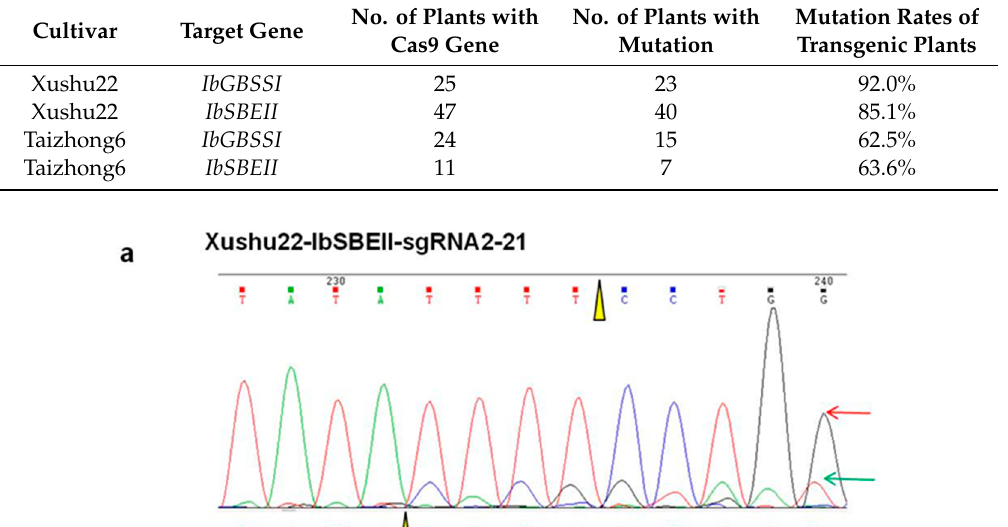
Table 1. Mutation rates of CRISPR / Cas9 in sweet potato. Figure 2. Schematic representation of the workflow designed to analyze targeted gene mutations of CRISPR/Cas9 editing. Transgenic lines were identified by PCR detection of Cas9 genes. Mutation detection in transgenic lines by PCR amplification with primers flanking the sgRNA target sites and running gel electrophoresis to roughly estimate the mutation types. PCR products sequencing analysis was performed by examining their sequencing chromatograms for accurate mutation status.